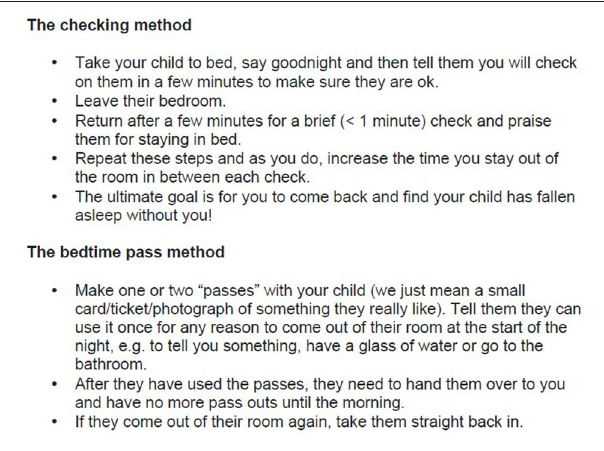
FIGURE 6 | Example content of module G, solving falling asleep problems. Multiple evidence-based strategies presented.